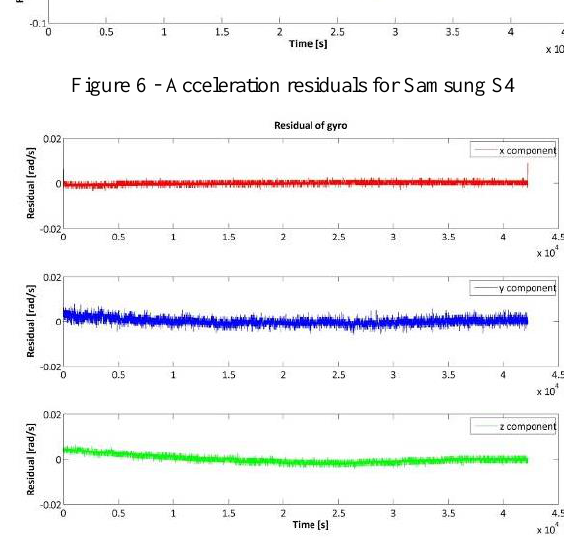
Figure 7 - Gyroscope residuals for Samsung S4